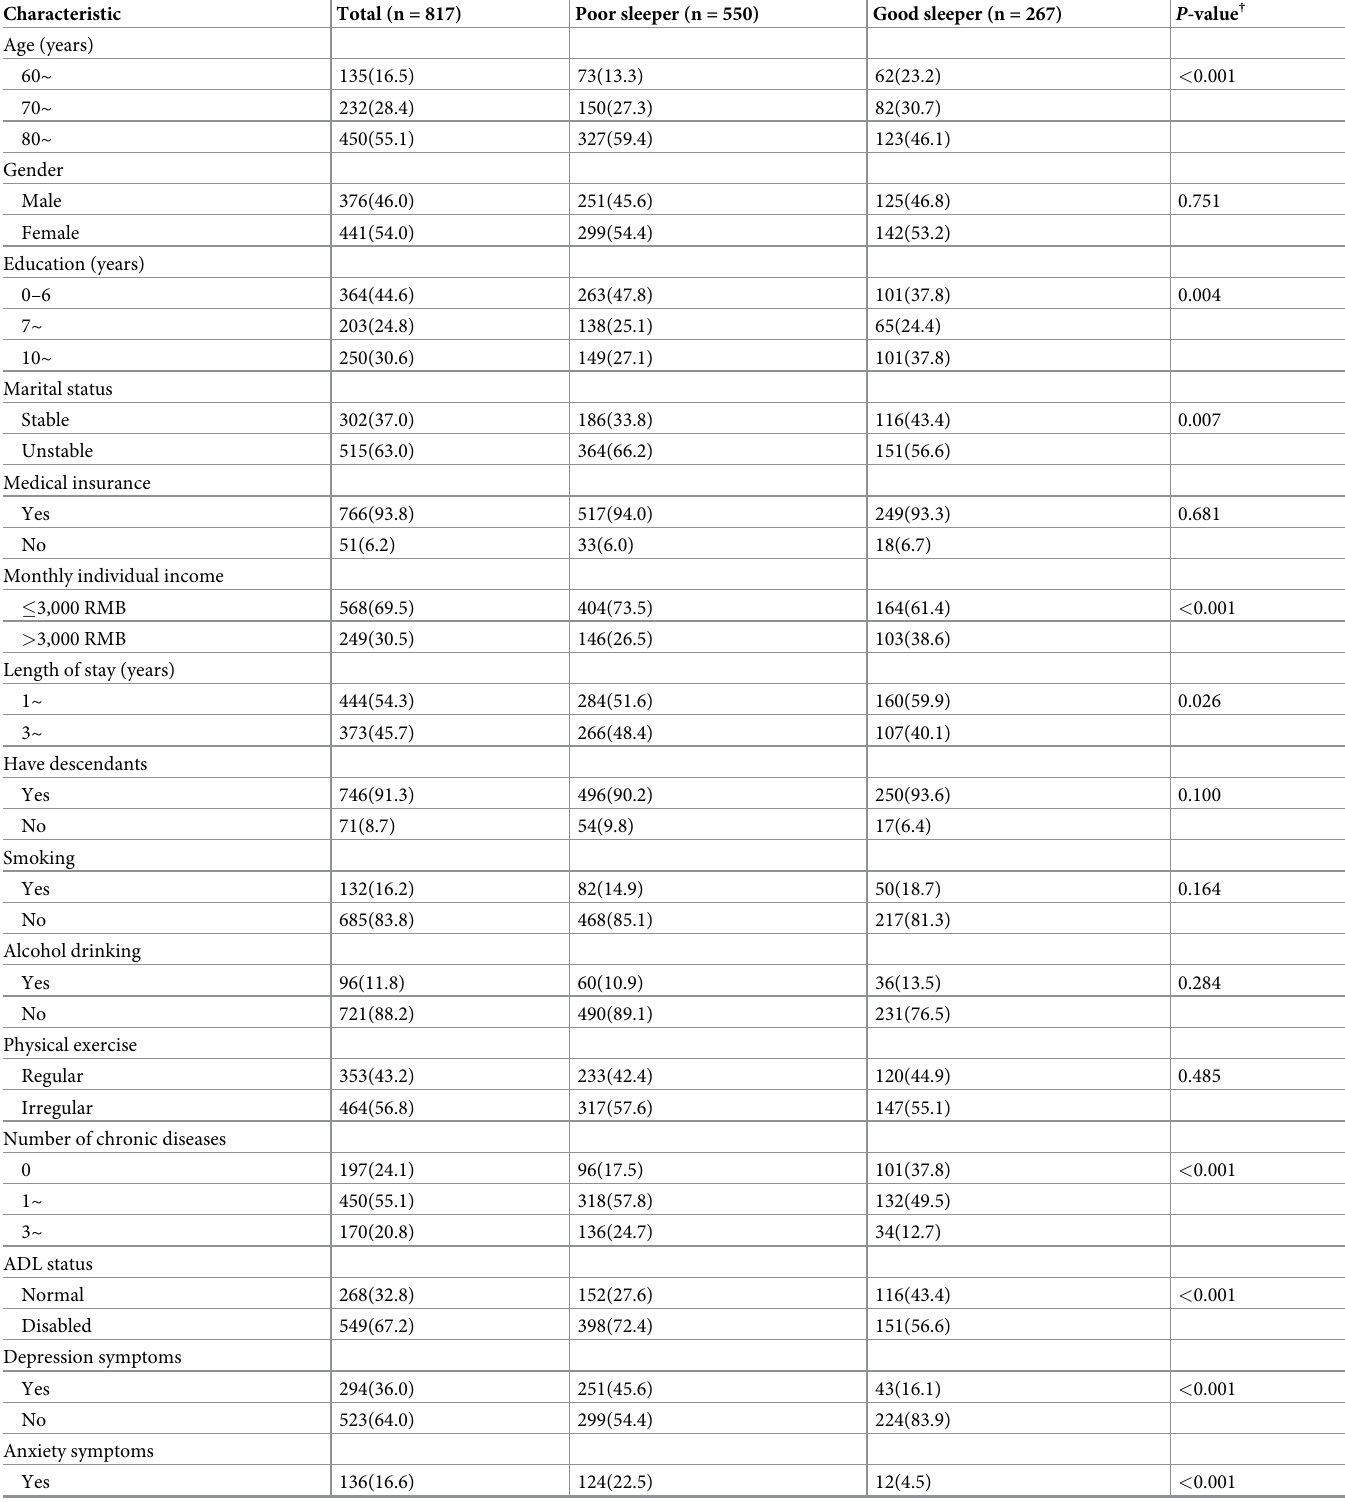
Table 1. Characteristics of the elderly residents in the nursing